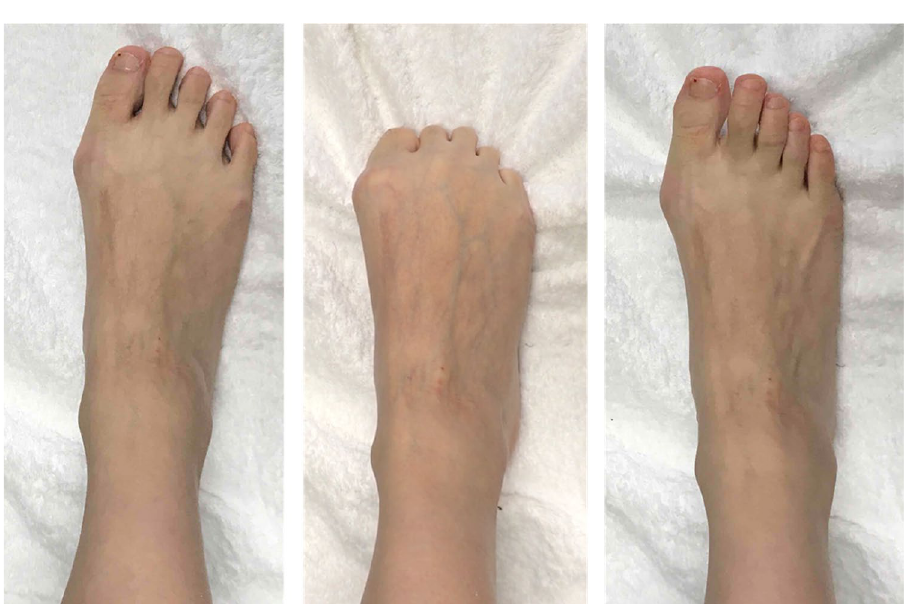
Figure 2. The towel-gathering exercise. With the heels on the floor, grasp the towel with the toes and repeat the movement of pulling it toward oneself and releasing